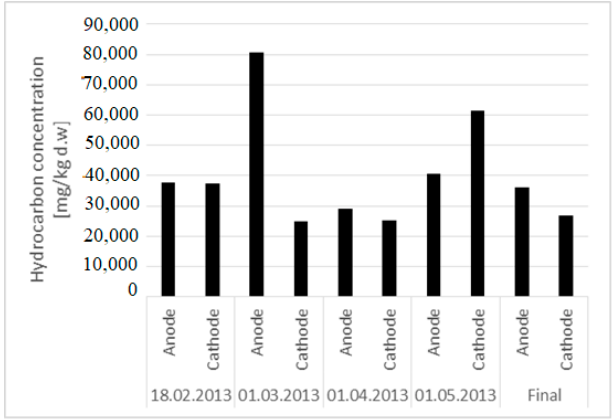
Figure 4. The trend of hydrocarbons during electrooxidation.